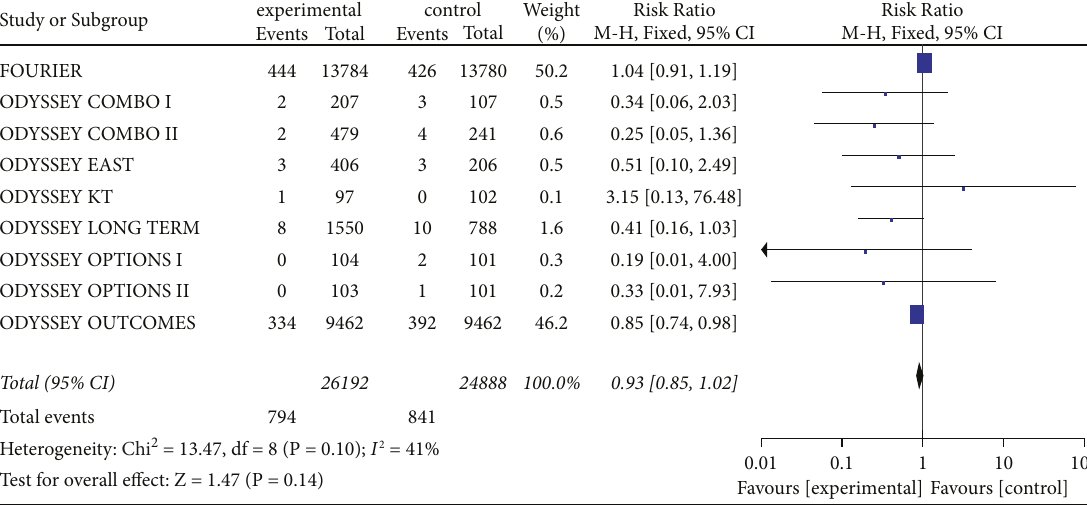
Figure 2: The all-cause mortality between two groups.